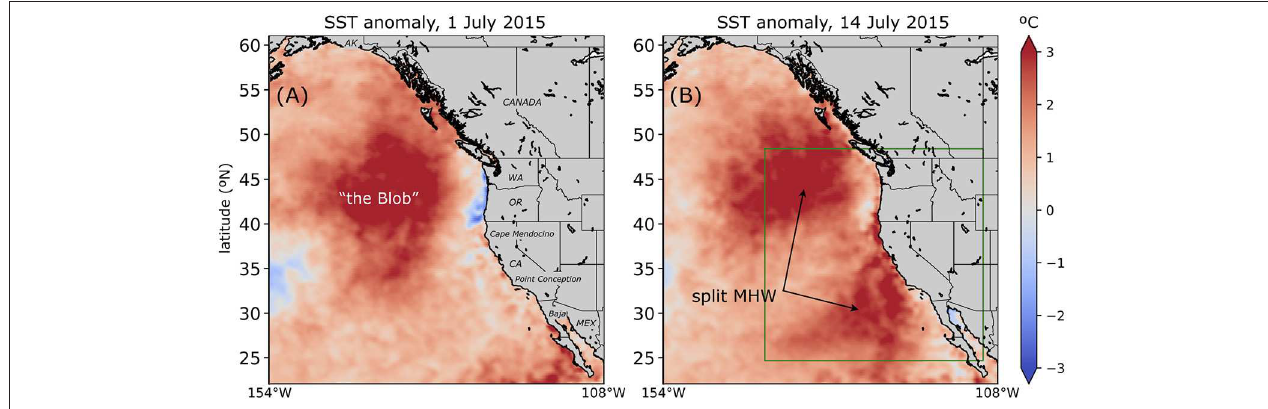
FIGURE 1 | SST anomalies before and after the formation of the July 2015 split MHW: (A) 1 July 2015 and (B) 14 July. The SST anomaly at each location is calculated relative to a daily long-term climatology using the CMC SST product (section 2.2). The vertical axis limits are 22 and 61 ◦ N. Green rectangle in (B) shows area covered by Figures 2 , 4